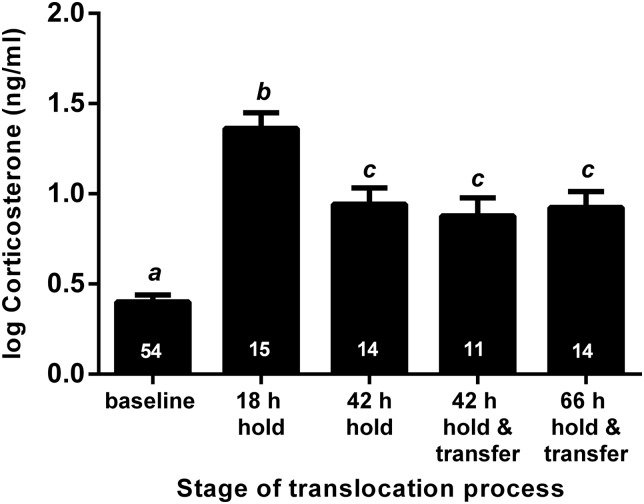
Short-term monitoring. The corticosterone response (in nanograms per millilitre) of tuatara (Sphenodon punctatus) at different stages of the translocation process during translocation A to Motuihe Island from Lady Alice Island in March 2012. Sample size (n) is indicated by the number at the base of each bar. Bars that share identical letters are not significantly different (P > 0.05).